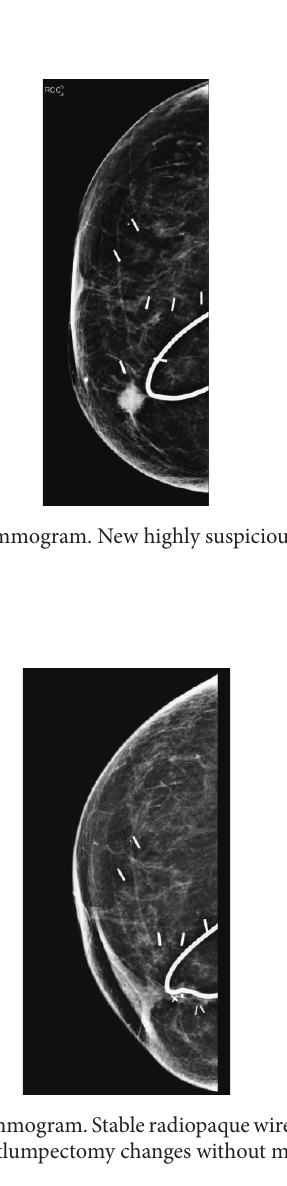
Figure 1: 2010 Mammogram. Indeterminate calcifications in right 12:00 retroareolar breast.